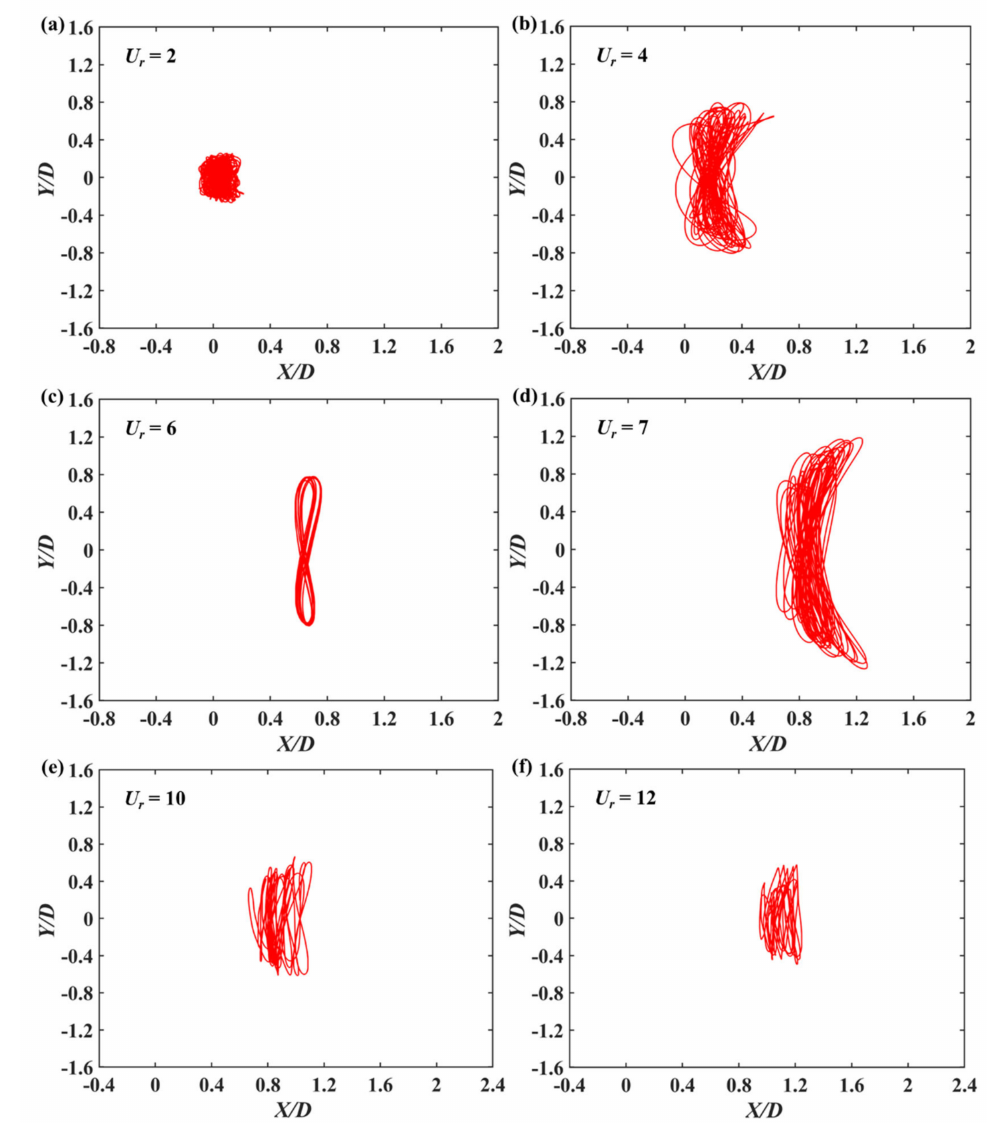
Figure 9. X-Y trajectory of two coupled cylinders at α = 180 ◦ and d/D = 0.3: ( a ) U r = 2; ( b ) U r = 4; ( c ) U r = 6; ( d ) U r = 7; ( e ) U r = 10; ( f ) U r =